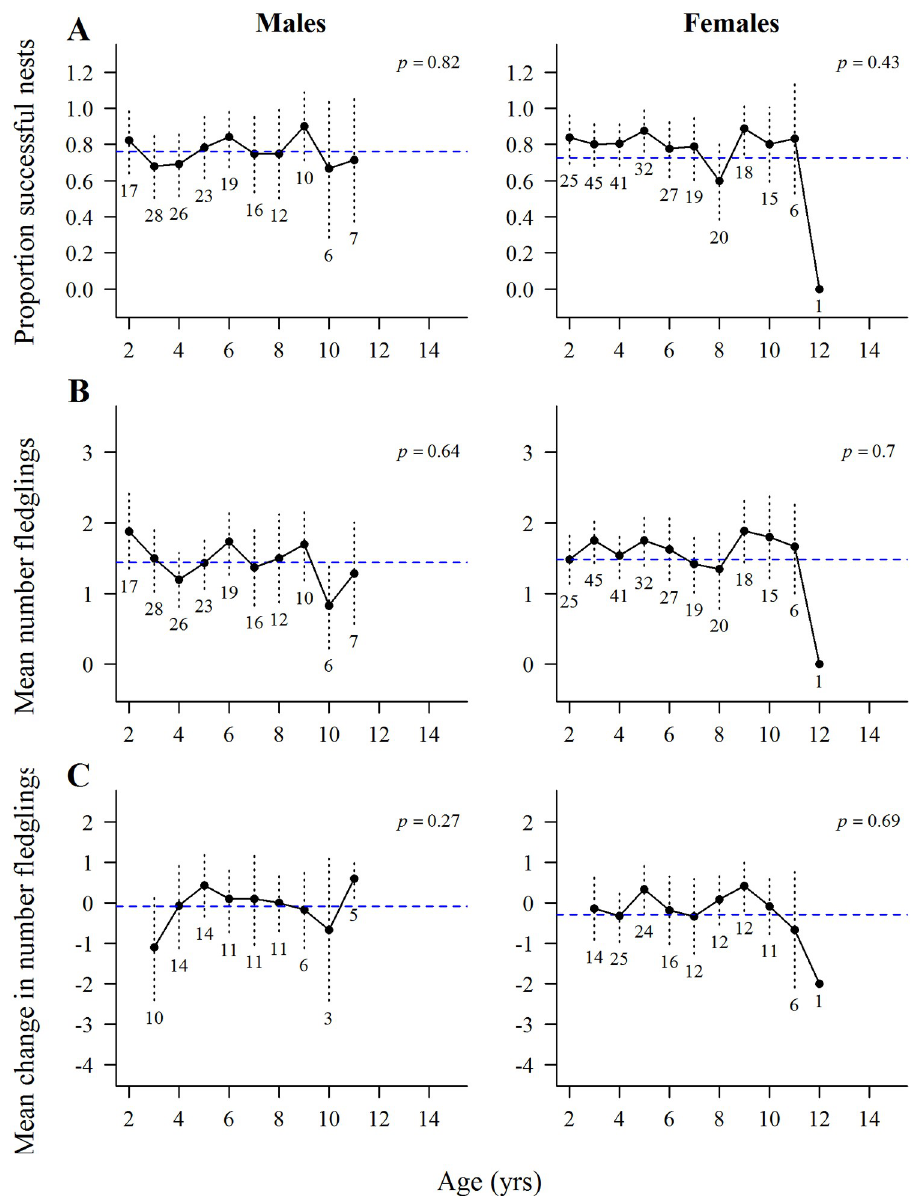
Fig 5. Age-specific reproduction by known-age goshawks. Means, ± 2 standard errors, and overall mean values (horizontal dashed line) of the raw data from GAMM analyses of age-specific reproduction by known-age male and female northern goshawks in Arizona, USA. Numbers below standard error bars indicate the number of males and females in each age group. (A) nest success (fledged � 1 young) as a function of age of 164 breeding attempts by 58 males and 249 attempts by 88 females, (B) fledgling production as a function of age in 164 breeding attempts by 58 males and in 249 attempts by 88 females (population-level analyses), and (C) changes in numbers of fledglings produced in 85 breeding attempts by 40 males and 133 breeding attempts by 55 females that bred in one and the next year (individual-level analyses).